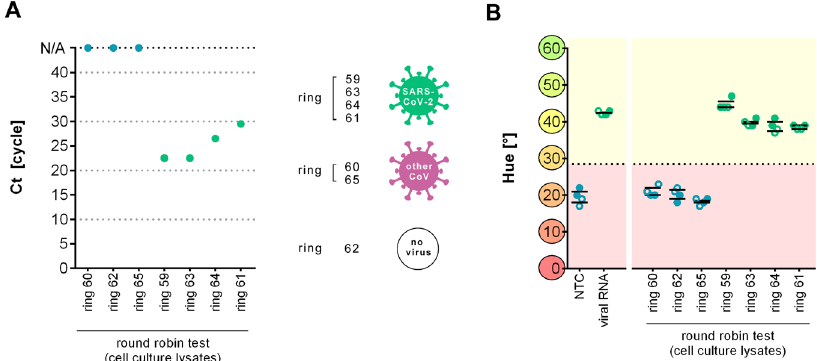
Fig. 3 Detection of SARS-CoV-2 in cell-culture supernatants provided for assay validation. A Ct values of individual cell-culture supernatant samples obtained via RT-qPCR assay targeting the SARS-CoV-2 E gene. B Hue of individual cell-culture supernatant samples after Cap-iLAMP measured in duplicates. Solid circles indicate values of the Orf1a assay while hollow circles denote values of the N gene assay. Data obtained from healthy individuals are shown in blue while SARS-CoV-2-positive patient samples are depicted in green. Assays with a hue >28.5° (dotted line) are considered positive. Source data are provided as a Source Data fi